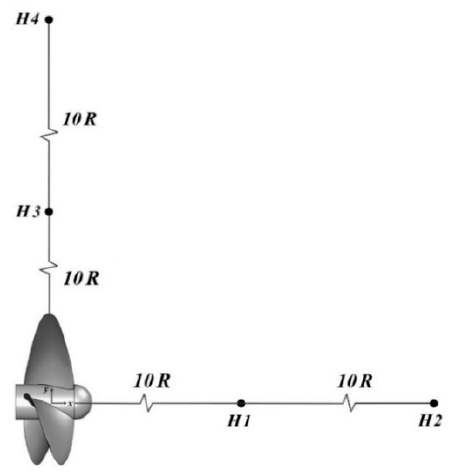
Figure 14. Location of hydrophones. Table 4. Coordinates of hydrophones.